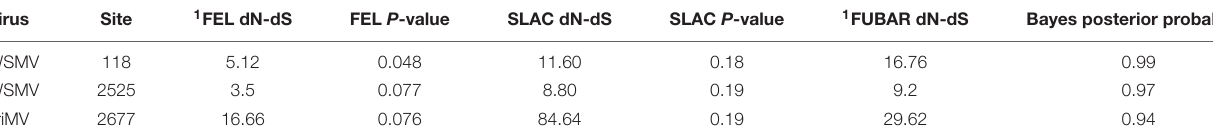
TABLE 3 | Codon positions of the coding regions in WSMV and TriMV isolates affected by positive selection.